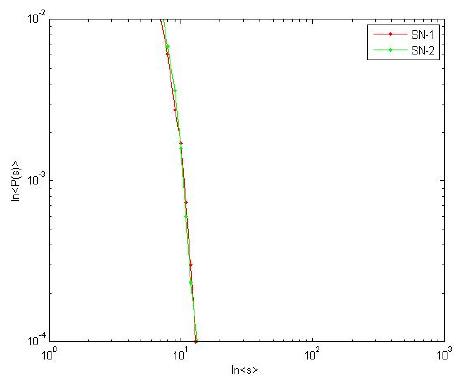
Figure 15. Avalanche size in supercritical state.